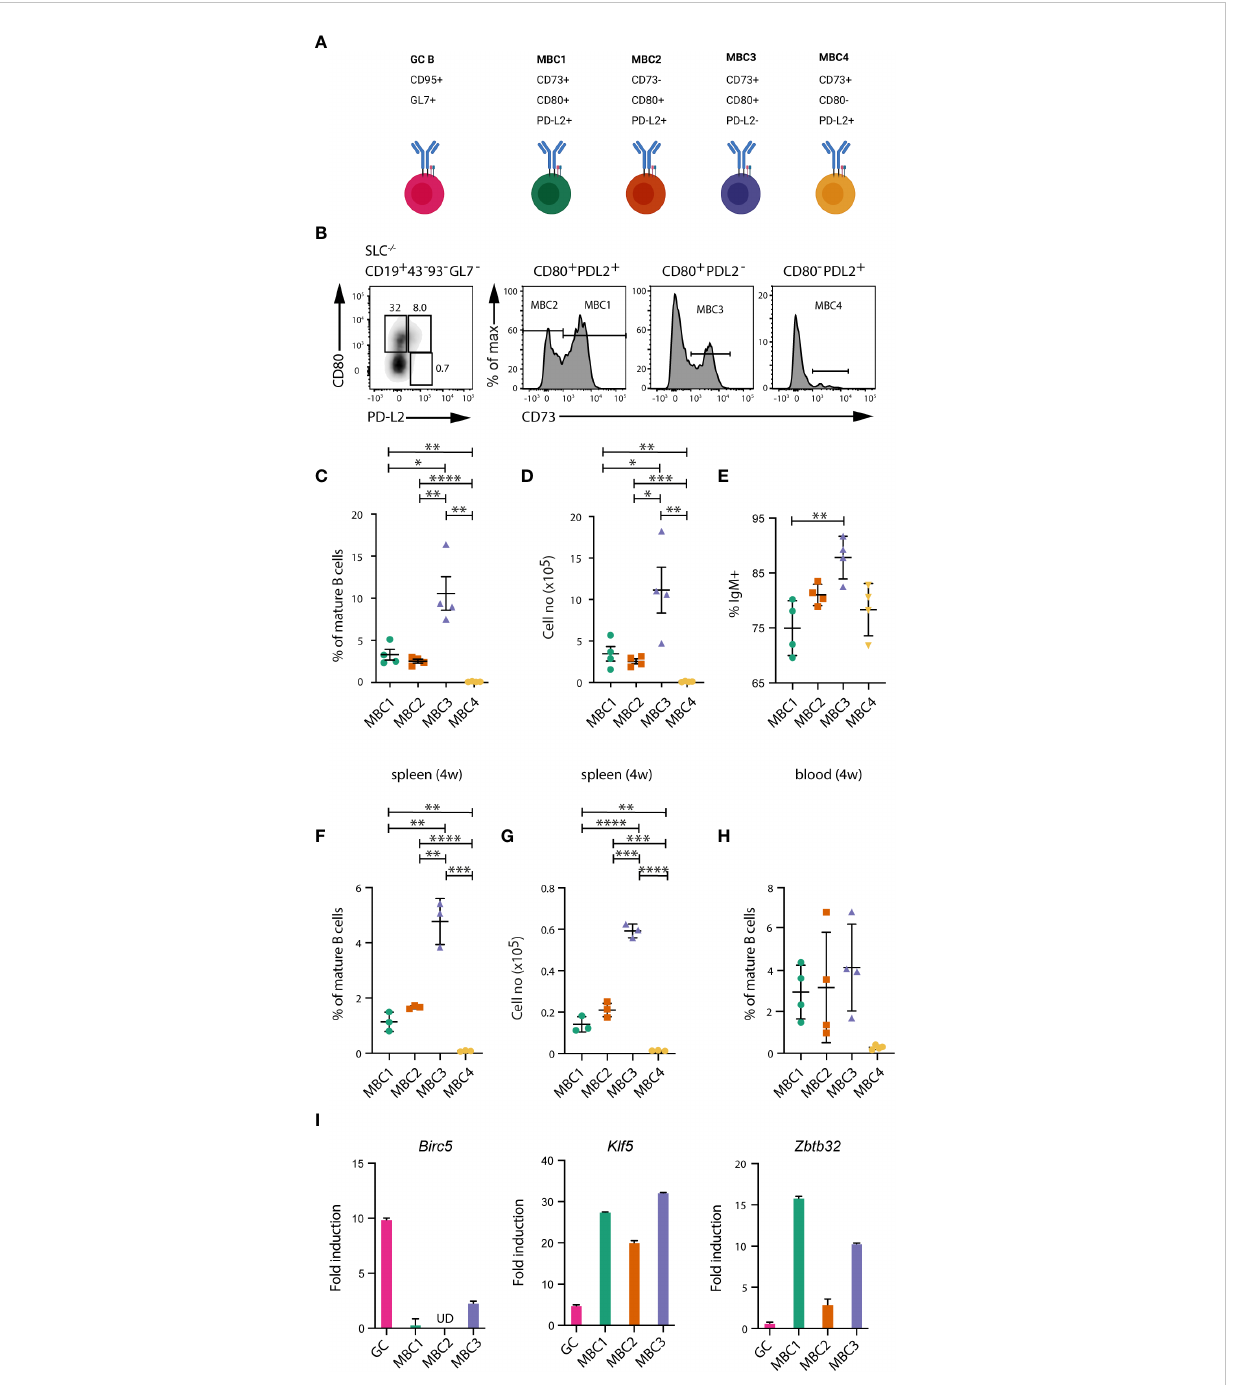
FIGURE 1 Several subsets of memory B cells in autoimmune mice. (A) Schematic overview of MBC subsets and their development in SLC -/- mice. Created with Biorender.com. (B – E) Flow cytometry analysis of spleen cells and peripheral blood leukocytes from SLC -/- mice. (B) FACS plots show the different MBC subsets. Cells are gated on CD19 + CD43 - CD93 - GL7 - mature B cells and then using CD73, CD80 and PD-L2 for detection of MBCs. (C, D) Graph shows the proportions (C) and absolute numbers (D) of MBC1 (CD73 + CD80 + PD-L2 + ), MBC2 (CD73 - CD80 + PD-L2 + ), MBC3 (CD73 + CD80 + PD-L2 - ) and MBC4 (CD73 + CD80 - PD-L2 + ). (E) Graph shows the proportions of IgM-expressing cells within MBC1-4 subsets. (F, G) Graph shows the proportions (F) and absolute numbers (G) of MBC1-4 in four weeks old SLC -/- mice. (H) Flow cytometry analysis of peripheral blood leukocytes from SLC -/- mice. Graph shows the different MBC subsets. Cells are gated as in (B) . (I) QPCR analysis of Birc5 , Klf5 and Zbtb32 mRNA levels in GC B cells and MBC subsets from SLC -/- mice, with b-actin as internal ctrl. Fold induction was calculated using a pool of FO B cells from WT mice (n=3) as reference (fold induction=1). Results in (B-F) are representative and from at least three independent experiments with n=4-6 in each experiment. Results in (G, H) are representative from two independent experiments with n=4-5 in each experiment. Results in (I) from two independent pools of 5-6 mice. *P < 0.05; **P < 0.01; ***P < 0.001; ****P <